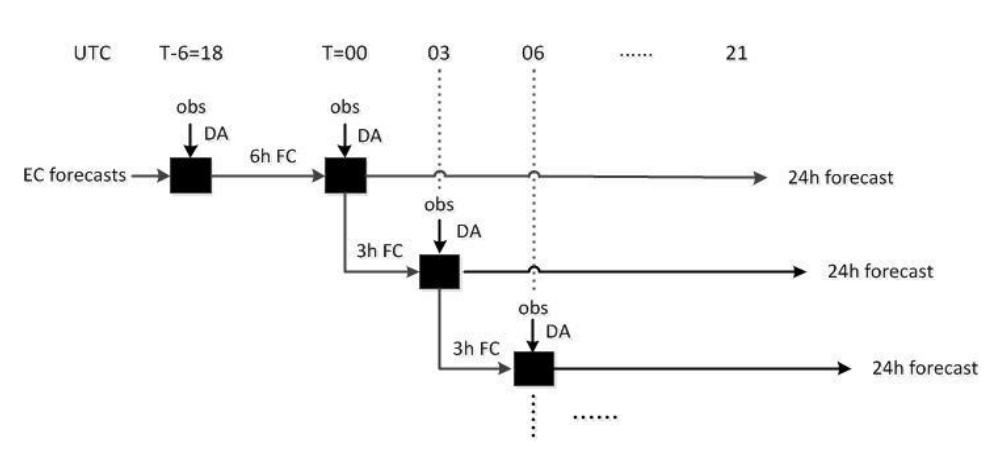
Figure 3. The schematic of data assimilation (DA) and forecast (FC) experiments in the RMAPS-ST.